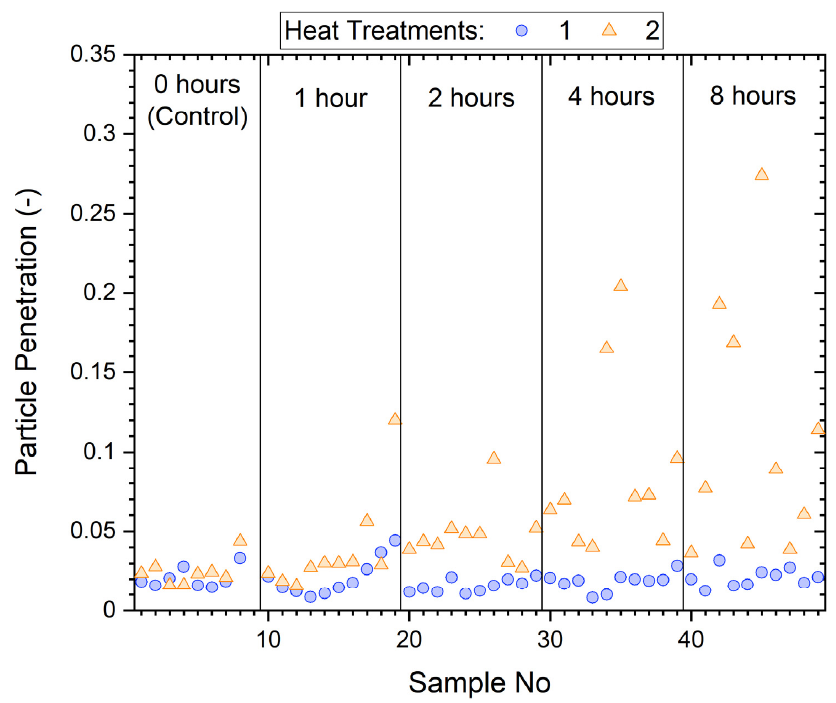
Figure 4. Penetration (P 0.3 ) of mask samples before (circle) and after (triangle) wearing for specified times (1, 2, 4, and 8 h) and control samples that were not worn. Before wear, samples had a penetration of ~2%, but after wear, penetration increased substantially for some samples (>10%), while others showed little change. Figure 5 plots all P 0.3 data from the wear trial delineated based on wear and heat (sanitization) treatment (point shape) and time of wear (point color) against the areal density for each individual sample. Data in Figure 5 are in paired sets: circles are used to plot measurements of samples after one heat treatment, while triangles show measurements after either wearing or the control (two heat treatments). The areal density is essentially unchanged in each pair.